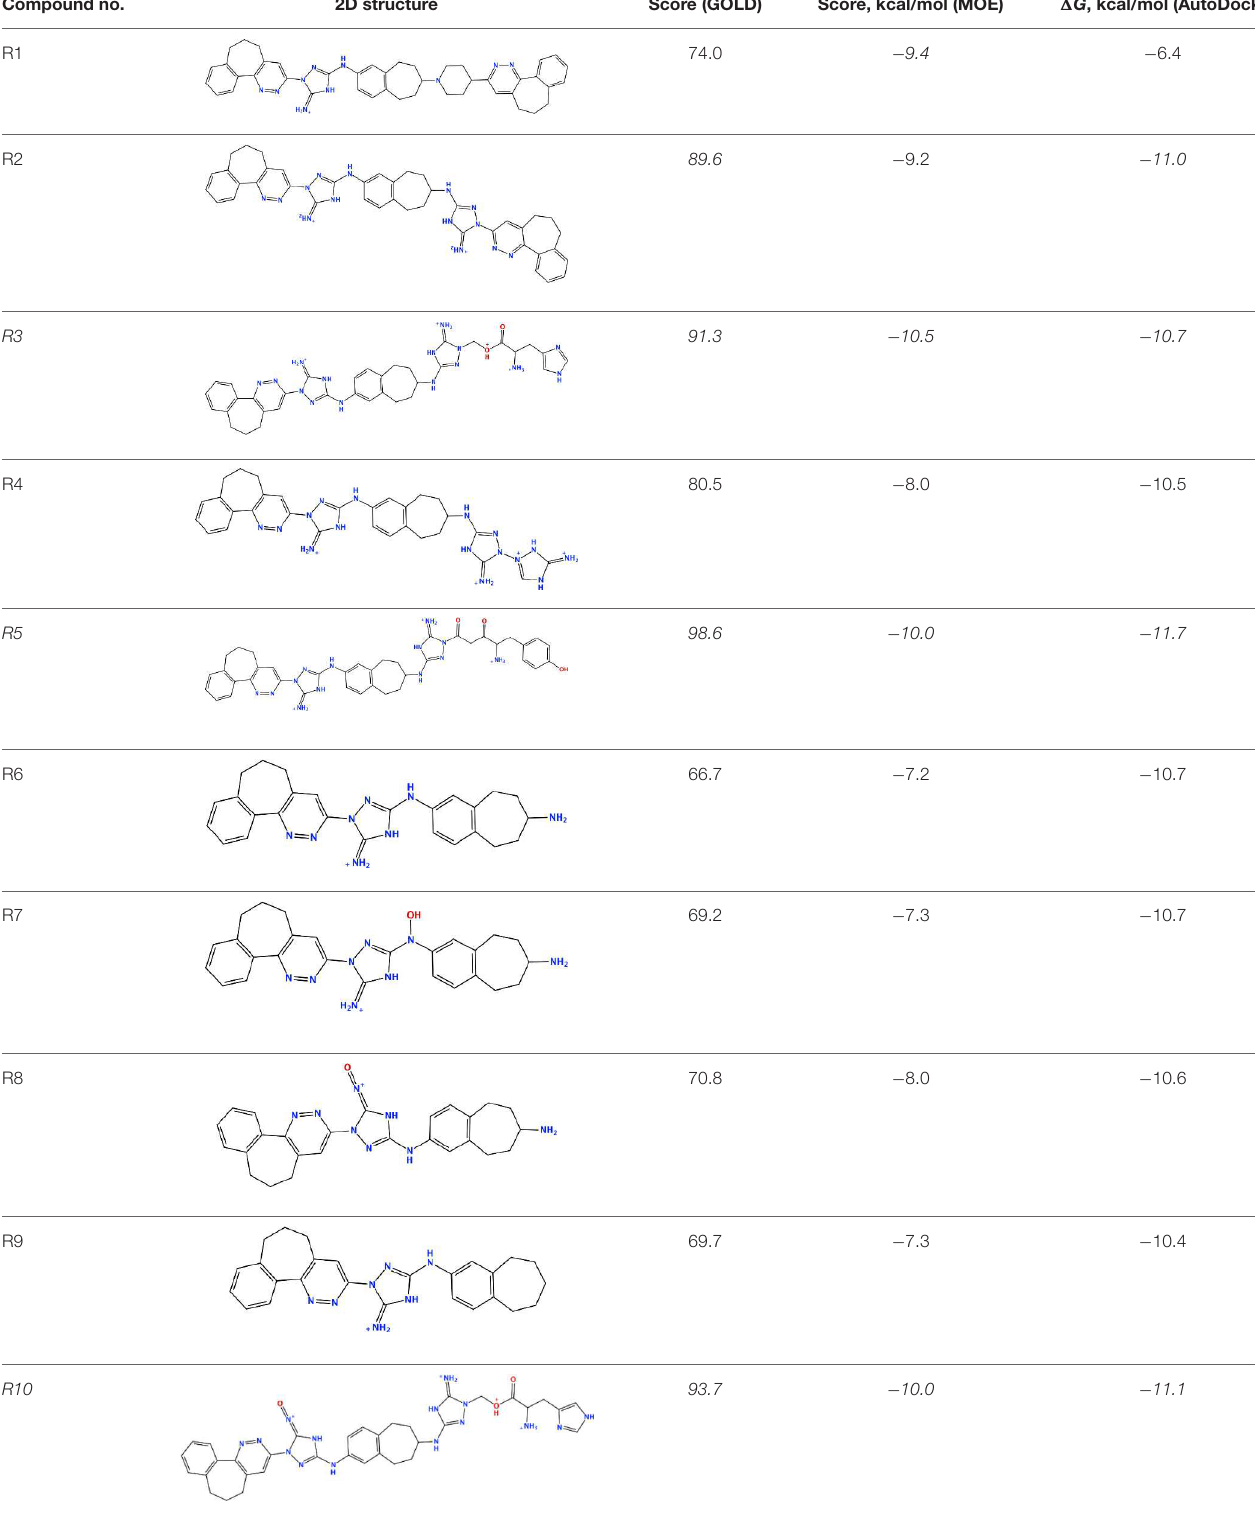
TABLE 5 | Docking scores according to the GOLD, MOE, and AutoDock software for the newly designed compounds—modifications of R428_1. Compound no.